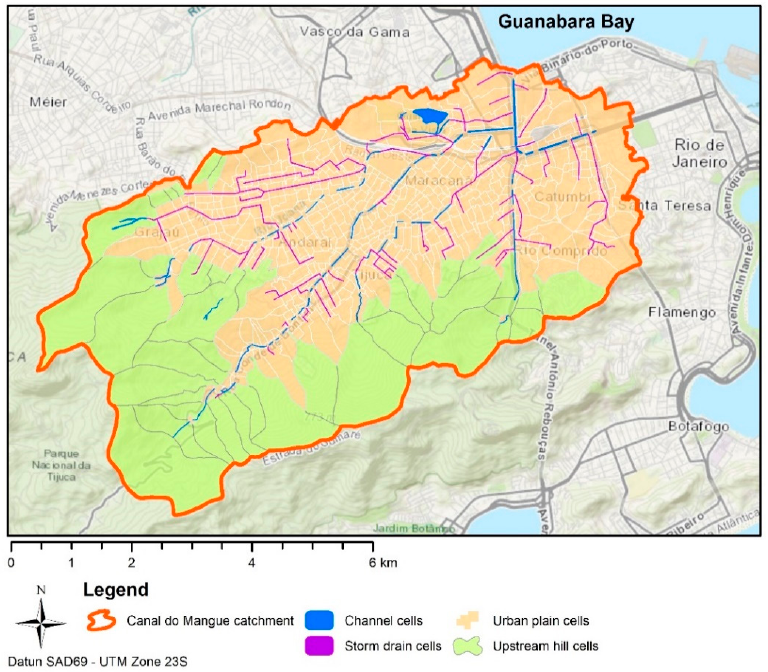
Figure 7. Division of the Canal do Mangue catchment in flow cells.